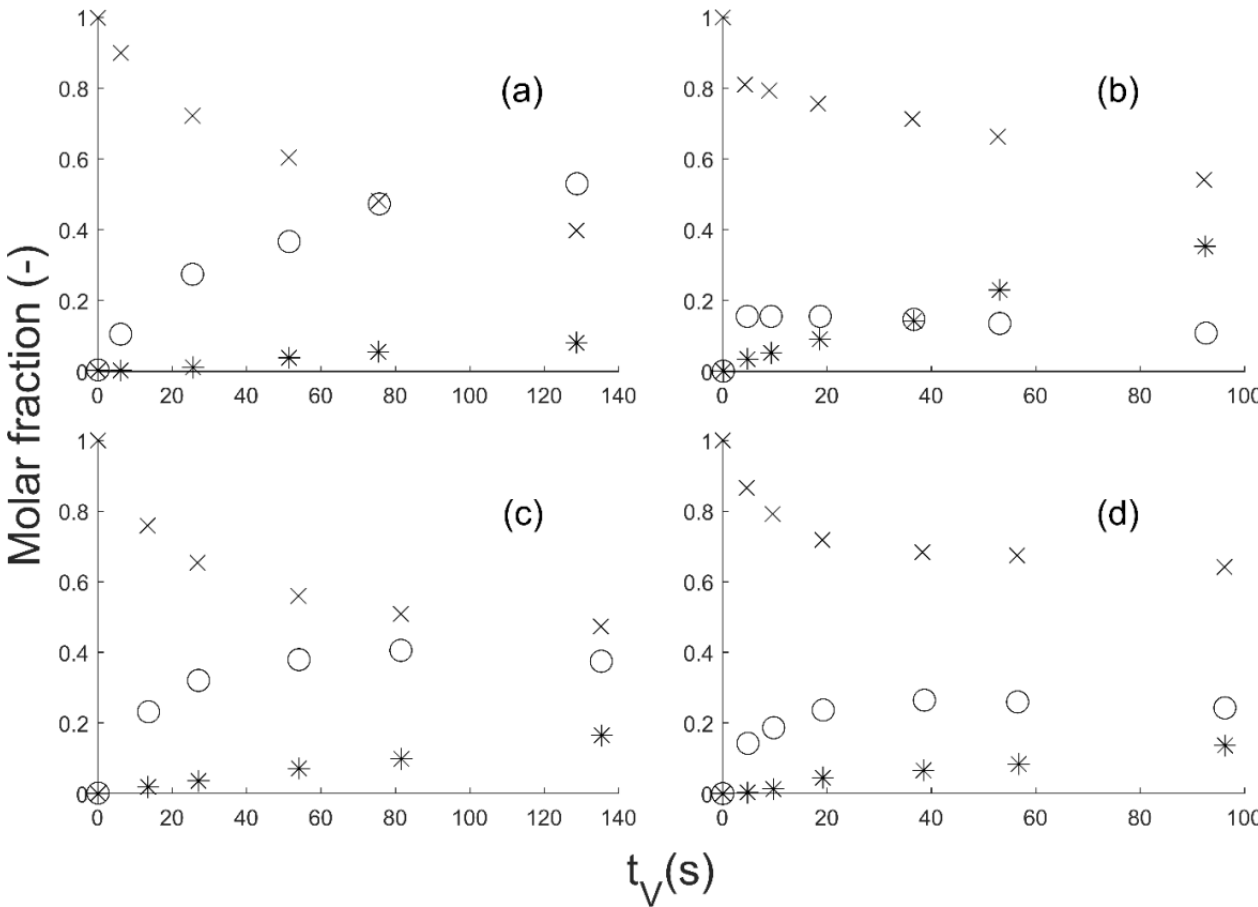
Figure 2. GBL (times cross), BDO (circle) and side products (SP) (star) molar fraction vs. time on stream (t V ): ( a ) 35 bar, 200 °C; ( b ) 25 bar, 240 °C; ( c ) 35 bar, 220 °C; ( d ) 25 bar, 220 °C. The data come from the Ph.D. thesis of J.H. Schlander [25], but were rearranged as a function of t V instead of the modified dwell time t mV .